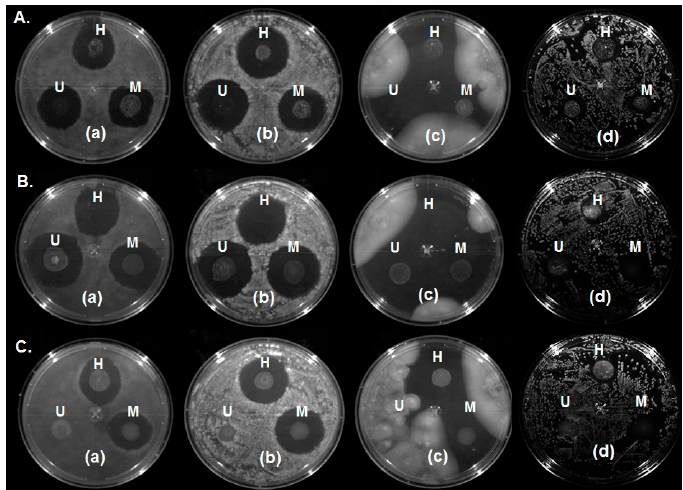
Figure 8. Antimicrobial effect of beeswax–starch nanoemulsion with ( A ) SA: stearic acid; ( B ) T80: Tween 80; and ( C ) T80/S60: Tween80/Span60 at different shear process against ( a ) R. stolonifer , ( b ) C. gloeosporioides , ( c ) B. cinerea , (d) S. Saintpaul. Emulsification process: U = ultrasound, H = homogenization, M = microfluidization.